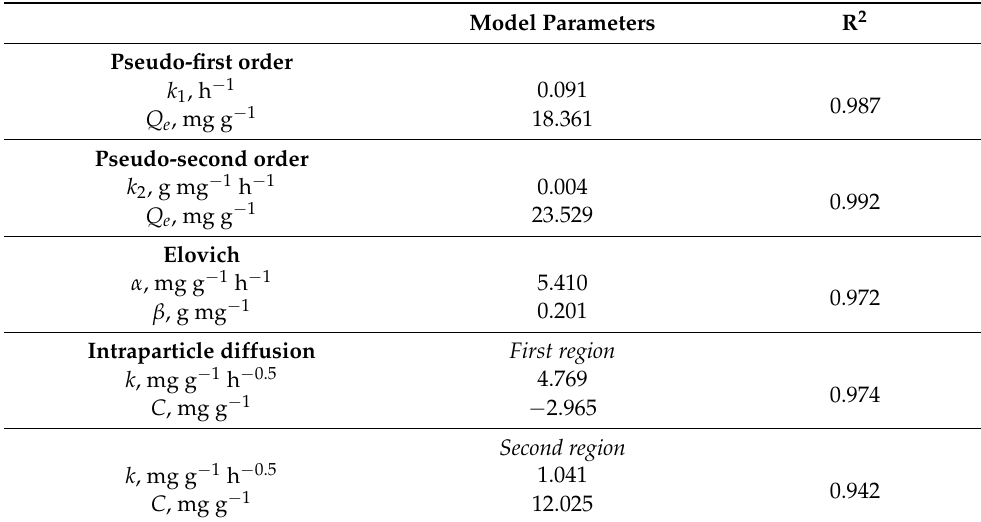
Table 3. Kinetic parameters for Cu (II) adsorption onto marble waste sludges. Model Parameters R